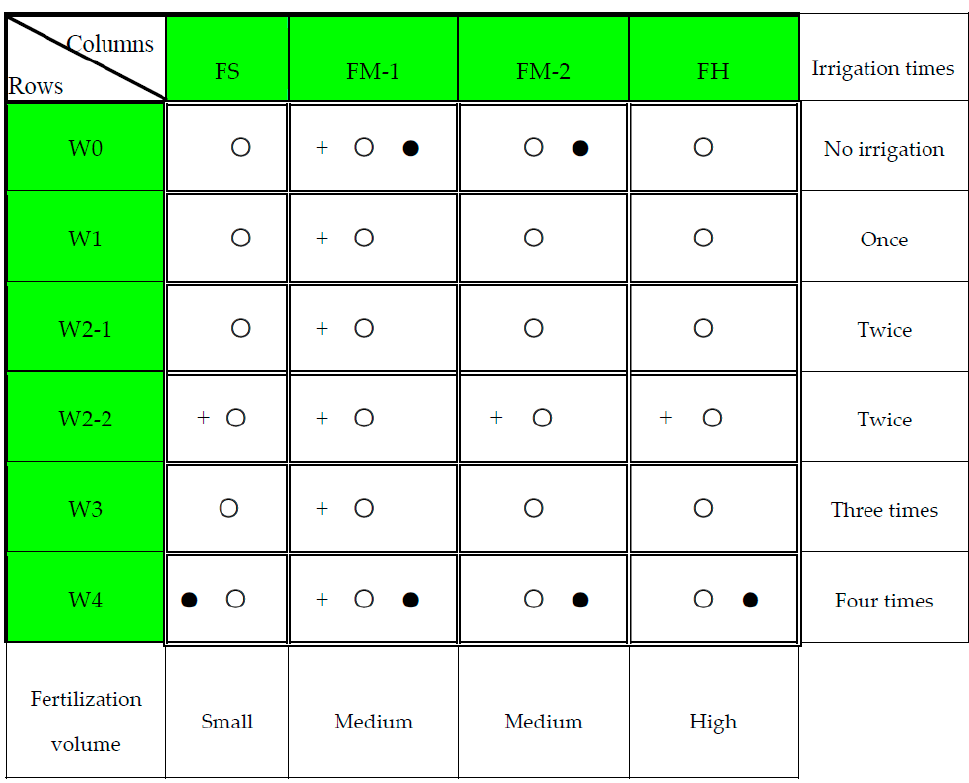
Figure 6. Field experiment plot layout. The open circle ( ○ ) denote the position of the neutron probe; the solid circle ( ● ) denote the position of soil temperature thermistor; the plus symbol (+) denote the crop growth index monitoring.